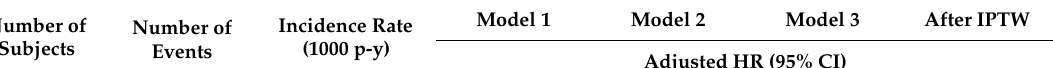
Table 2. Risk of cardiovascular event according to CKD and